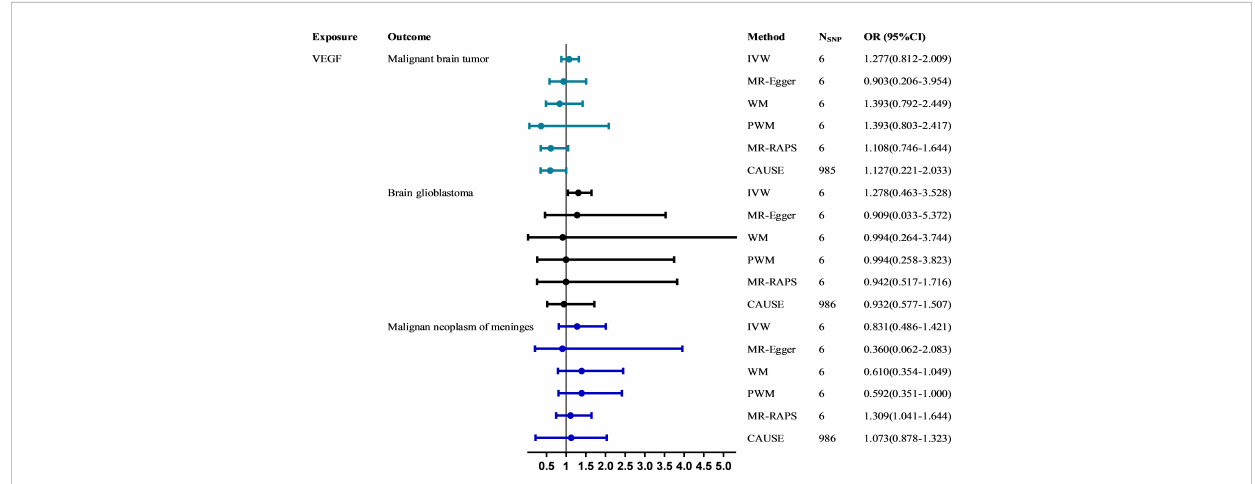
FIGURE 2 The causal effect of VEGF on the risk of malignant brain tumors estimated using six MR methods. The causal effect of VEGF on malignant brain tumor risk was expressed as the OR per unit. Error bars represent the 95% CIs of the estimates. CAUSE recruited independent instrumental SNPs with GWAS p values < 1×10 -3 . SNP: single-nucleotide polymorphism; VEGF: vascular endothelial growth factor; IVW: inverse-variance weighted; WM: weighted median; PWM: penalty weighted median; MR.RAPS: robust adjusted pro fi le score; CAUSE: causal analysis using summary effect estimates; OR: odds ratio; SD: standard deviation; CIs: con fi dence intervals; MR: Mendelian